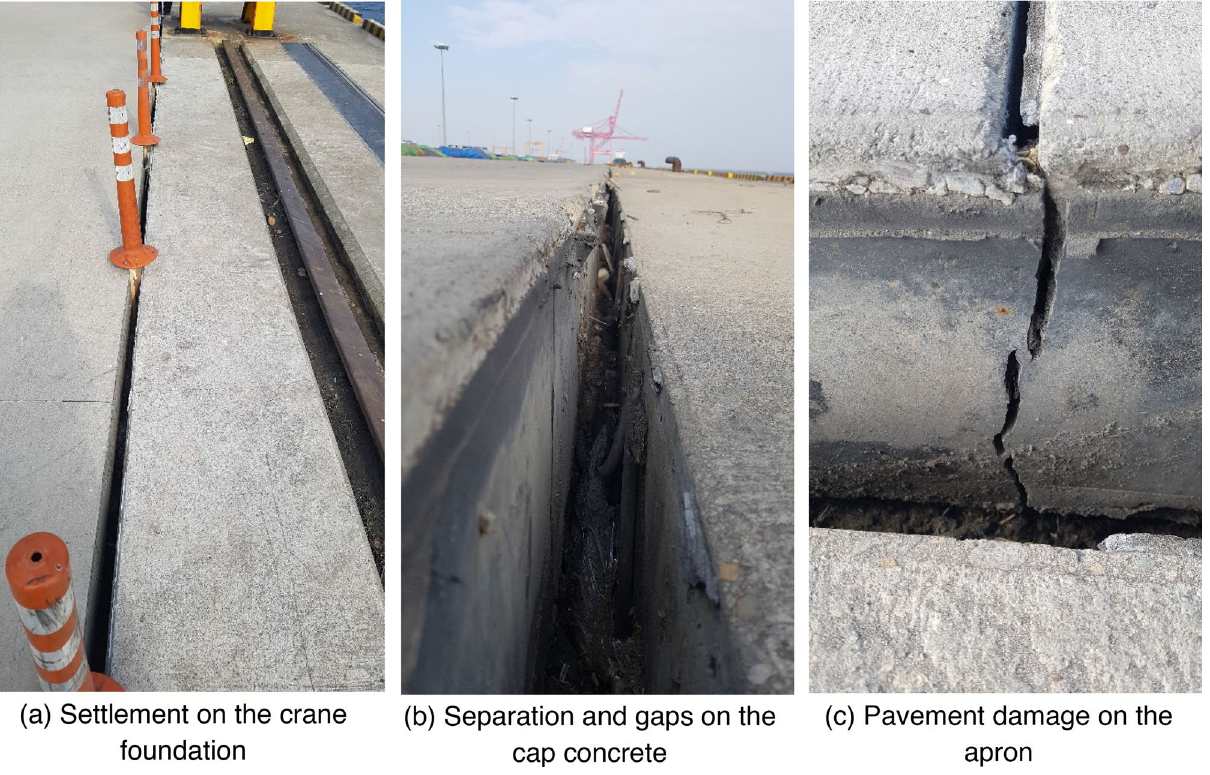
Figure 1. Earthquake damage in Pohang International Container